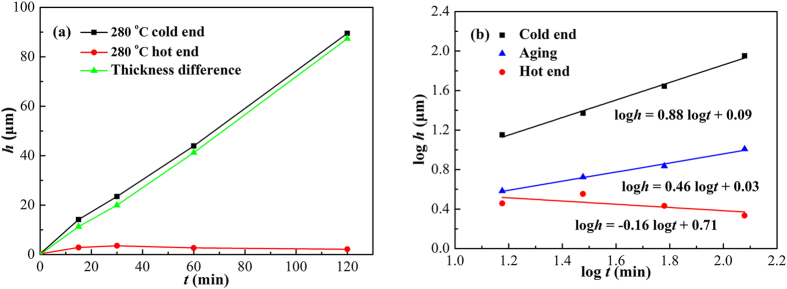
Thickness of interfacial Cu6Sn5 as a function of TM time at 280 °C: (a) h–t; (b) logh–logt.